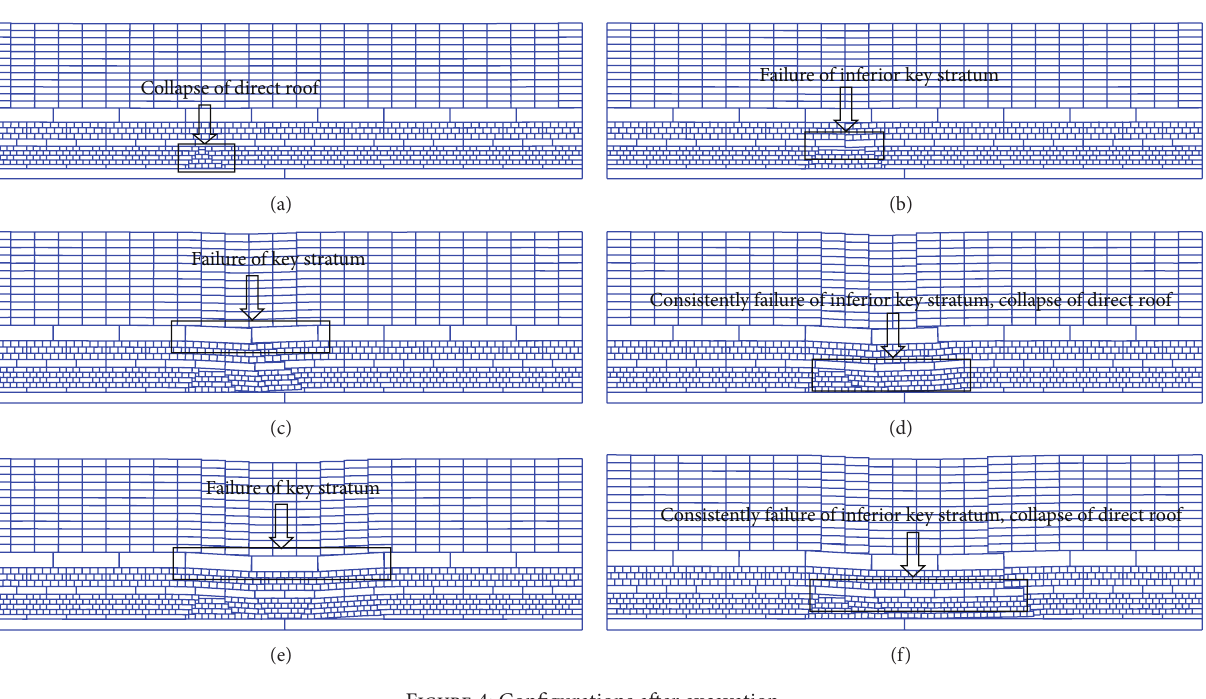
Figure 4: Configurations after